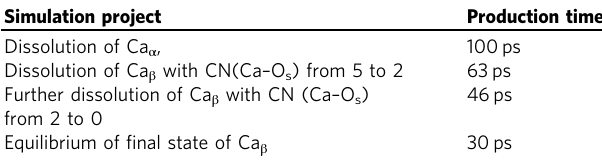
Table 1 The production times for all the simulation